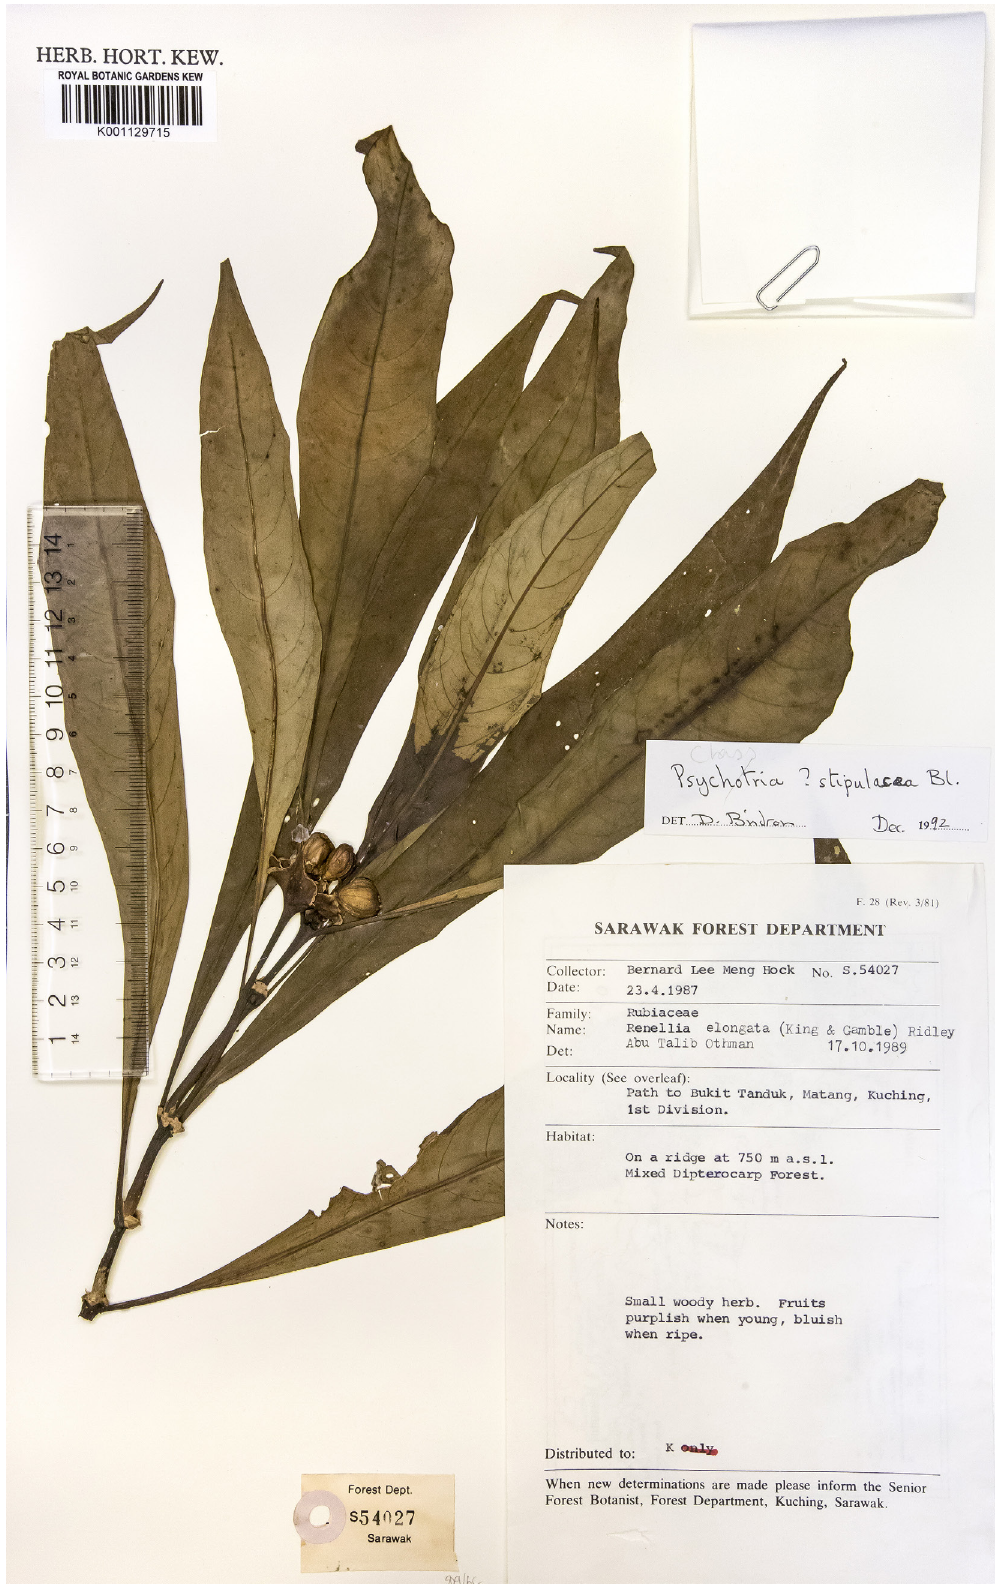
Fig. 23. Holotype of Chassalia macrocarpa T.Y.Yu sp. nov. ( Bernard Lee Meng Hock S 54027